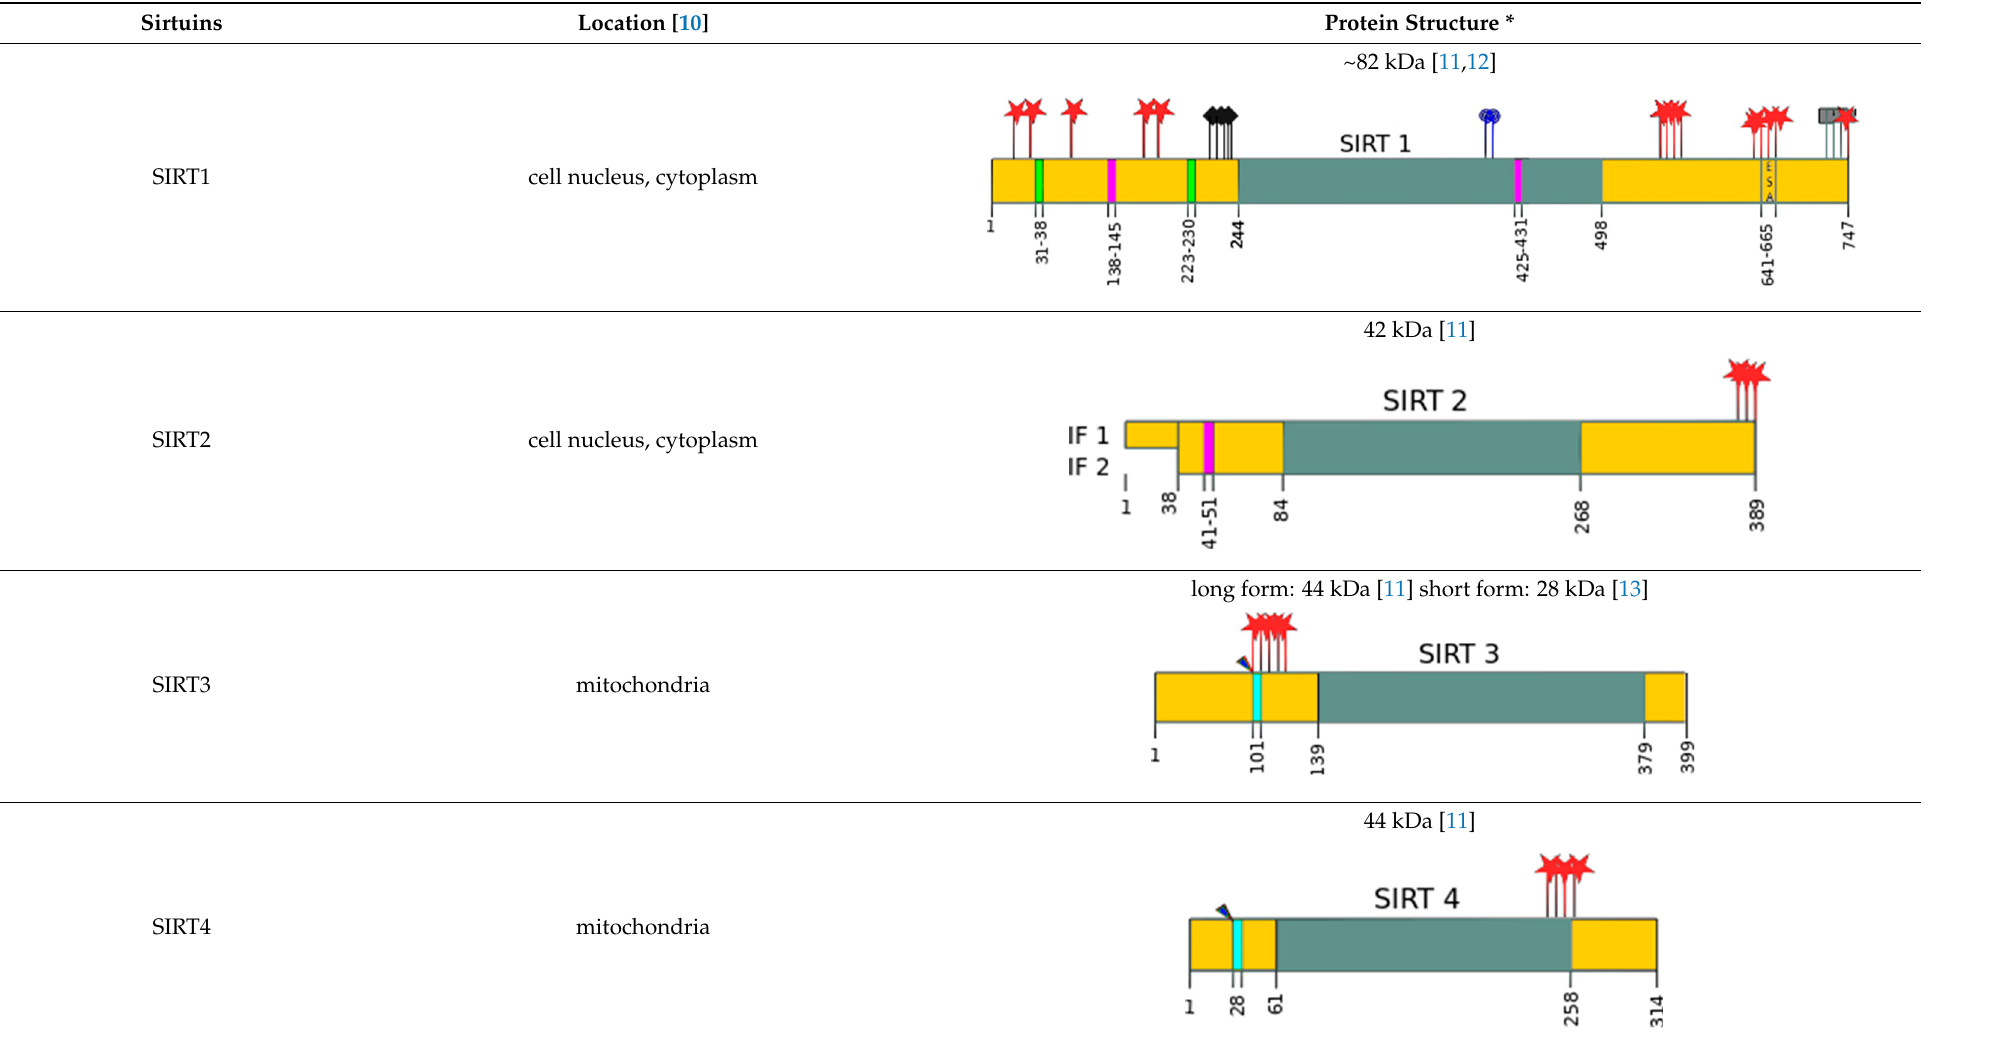
Table 1. Human SIRTs—structure and target